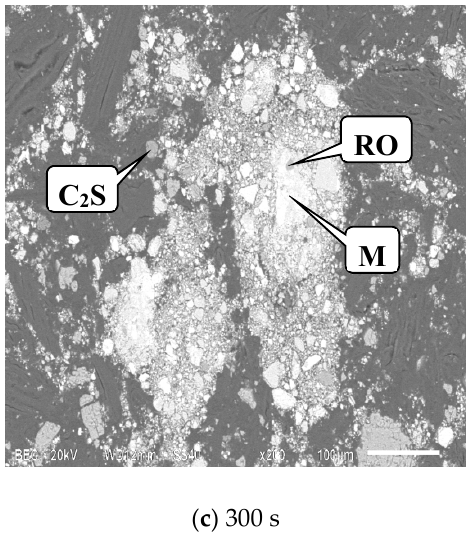
Figure 6. SEM images of the upper modified slag after different grinding times.